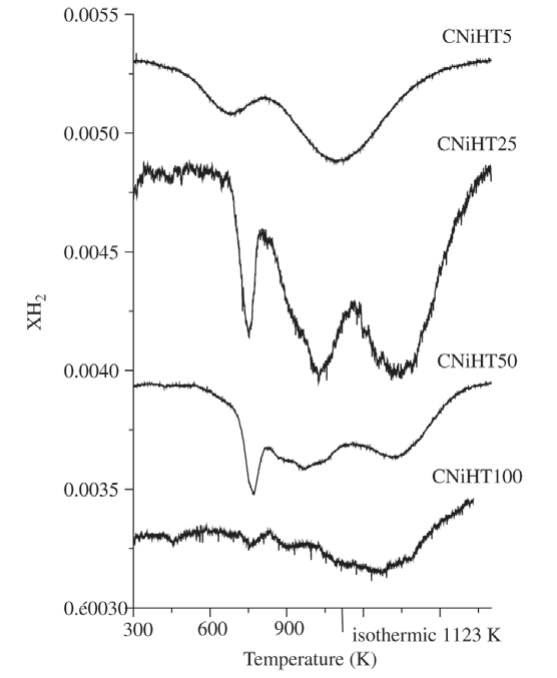
Figure 5. Thermoprogrammed reduction profile of calcined sam- ples (723